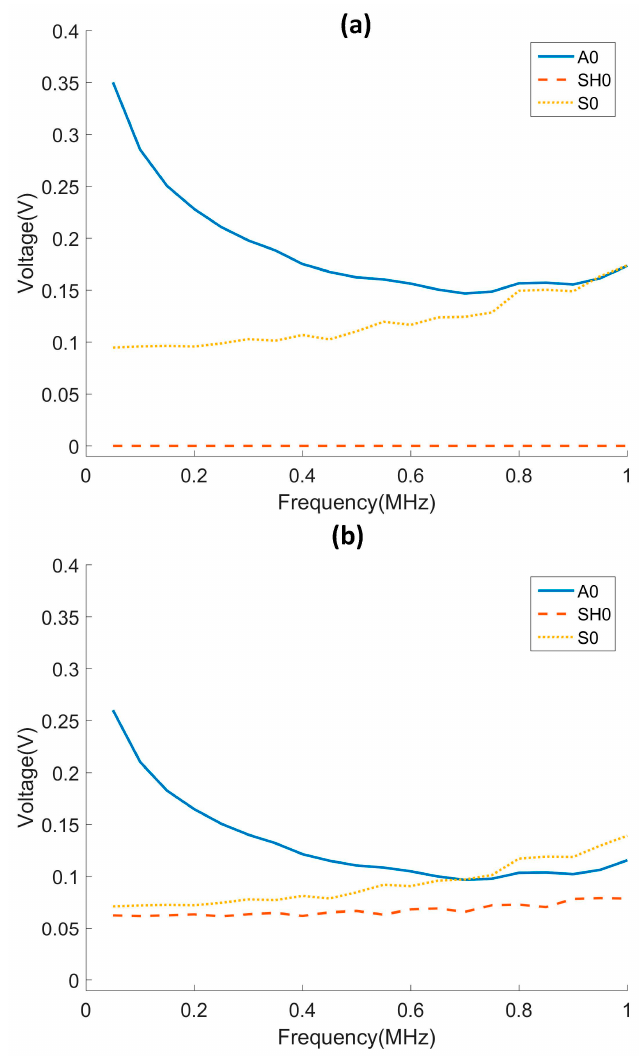
Figure 4. Received voltages with ( a ) 0° and ( b ) 45° PVDF film for Lamb wave modes A0 and S0 and SH mode SH0 for frequencies up to 1 MHz.